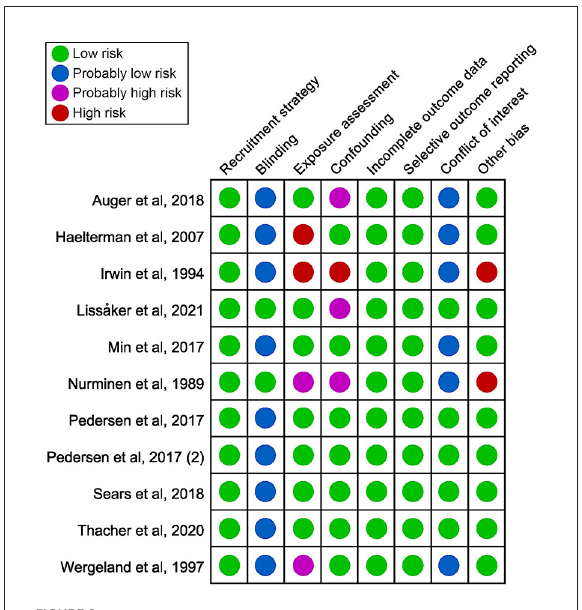
FIGURE2 Summary of the risk of bias judgments for each included study.